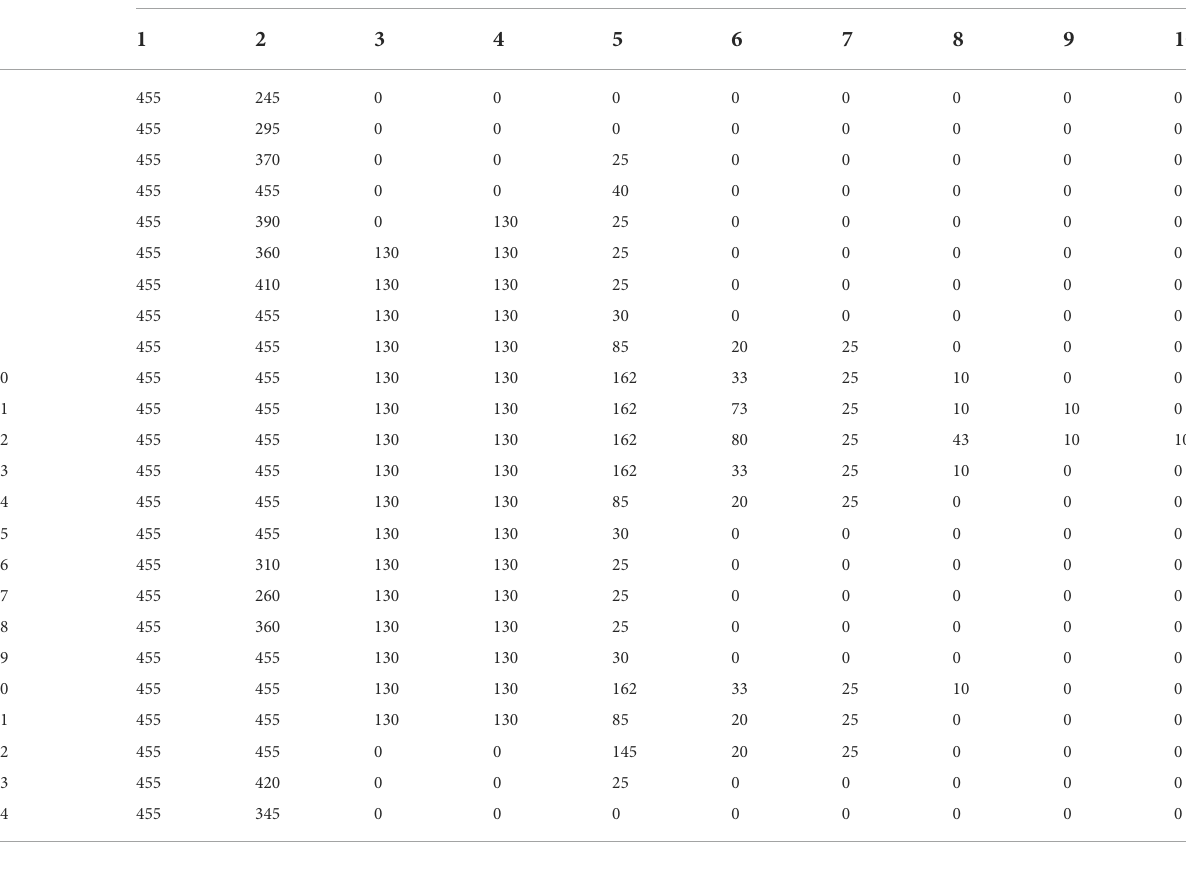
TABLE 3 Economic Dispatch for 10-unit system.